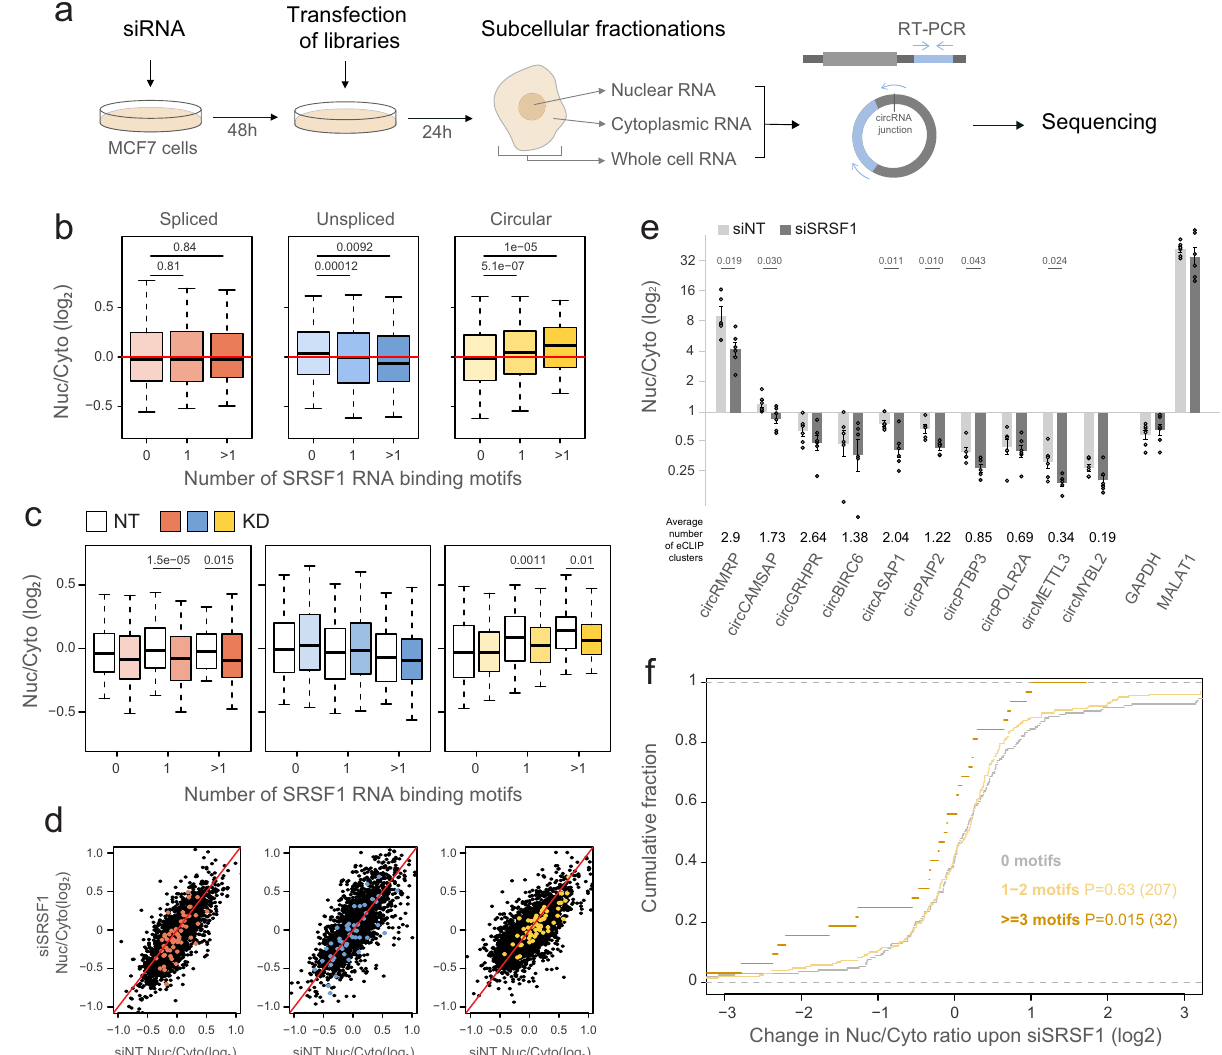
Fig. 3 The effect of SRSF1 KD. a Outline of the experimental procedure; cells were transfected fi rst with a pool of siRNAs. After 48 they were transfected with NucLibA libraries, and were fractionated after an additional 24 h into nuclear and cytoplasmic fractions. Libraries for sequencing were generated from total, nuclear, and cytoplasmic RNA. b Nuc/Cyto ratios of tiles with the indicated number of SRSF1 motifs in each context; spliced (red), unspliced (blue), and circular (yellow). n = 3 biologically independent samples. Box plots show median, fi rst to third quartile, whiskers are 1.5× interquartile range. P -values were computed using two-sided Wilcoxon rank-sum test. c Nuc/Cyto ratio of tiles with the indicated number of SRSF1 motifs following transfection of NT control (white) and siSRSF1 (colored as in b ). n = 3 biologically independent samples. Box plots are as in ( b ). P -values were computed using two-sided Wilcoxon rank-sum test. d The effect of factors depletion on subcellular localization; Nuc/Cyto ratio of tiles in SRSF1 KD samples vs. NT control samples of all tiles (black), and tiles that have >1 motif (colored). Red line indicates X = Y. e qPCR analysis of nuclear and cytoplasmic fractions following transfection of siNT and siSRSF1 n = 6 biologically independent samples. Data are presented as mean values + / − SEM. The average number of SRSF1 eCLIP clusters across replicates in HepG2 cells is shown below each circRNA. f Change in Nuc/Cyto ratio for circRNAs with the indicated number of SRSF1 binding motifs. P -values are for comparing the indicated group with circRNAs with no SRSF1 motifs and were computed using a two-sided Wilcoxon rank-sum test. Number of circRNAs in each group is indicated in parentheses. Source data are provided as a Source data fi